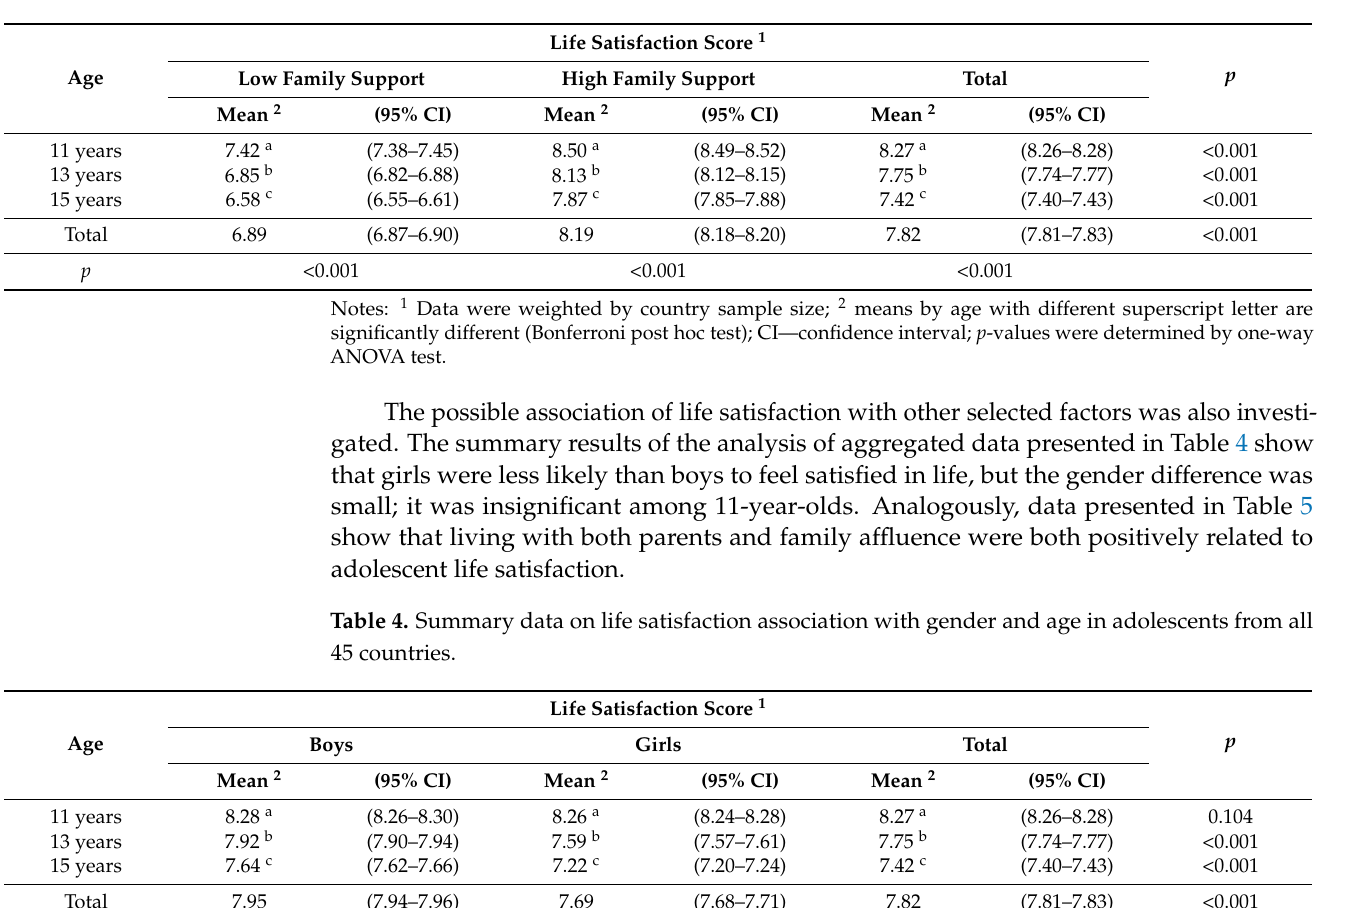
Table 3. Summary data on life satisfaction association with family support and age in adolescents from all 45 countries.